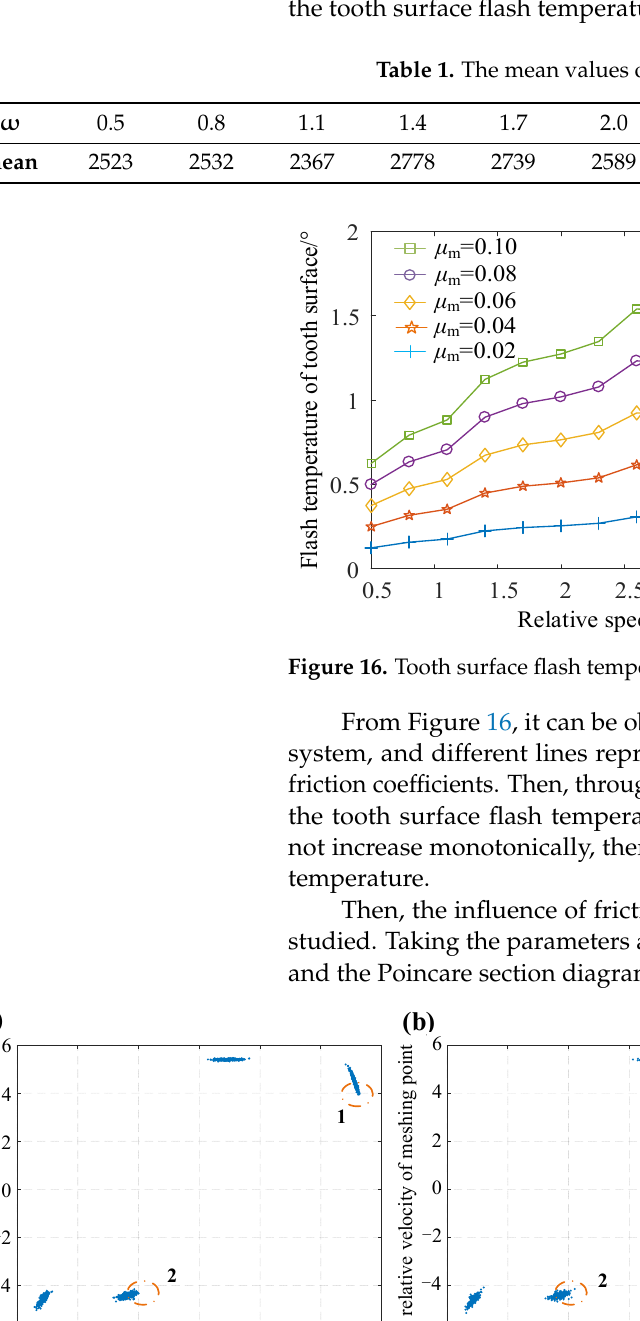
the meshing forces are shown in Table 1. Taking the parameters as ω = 0.5–4, µ m = 0.02–0.1,